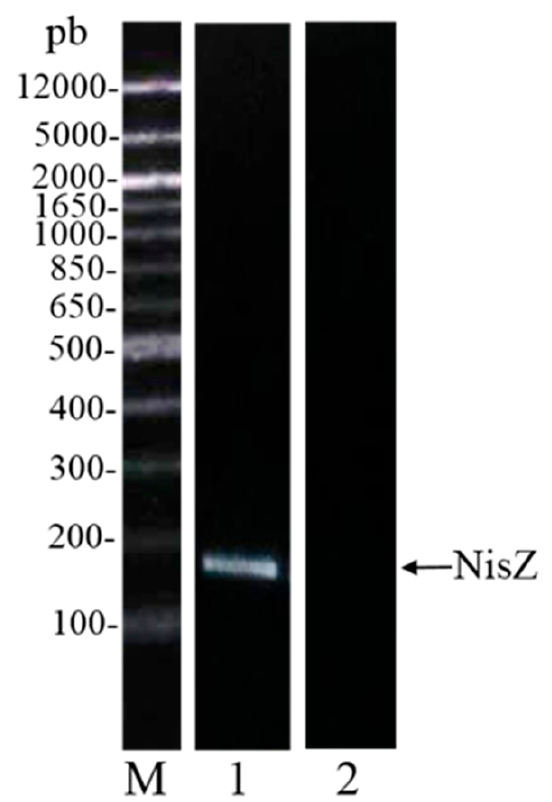
Figure 1. Identification of the NisZ gene at 174 bp, for the strain L. lactis 41FLL. M = molecular markers, Lane 1 = L. lactis 41FLL, Lane 2 = negative control.